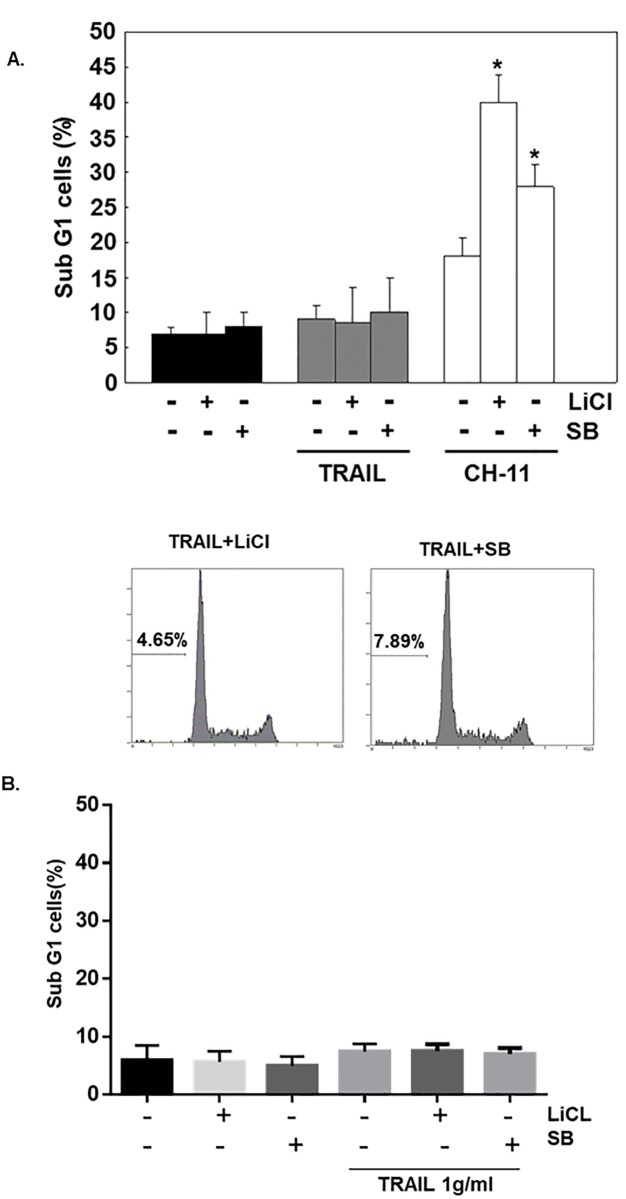
Effects of GSK-3 inhibitor on apoptosis induced by agonistic anti-CD95 and TRAIL in primary human gastric epithelial cells.(A) Treatment of normal human primary gastric epithelial cells with or without TRAIL (25ng/mL), agonistic anti-CD95 antibodies (25ng/mL), LiCl (20mM) or SB (25μM) for 24 hours. Then sub-G1 cells were analyzed by flow cytometry. The result was the mean of three independent experiments. The statistical significance was determined by comparison with primary gastric epithelial cells incubated with agonistic anti-CD95 antibodies only (*, p < 0.01). (B) Treatment of normal human primary gastric epithelial cells with or without TRAIL (1mg/mL), LiCl (20mM) or SB (25μM) for 24 hours. Then sub-G1 cells were analyzed by flow cytometry. The result was the mean of three independent experiments.